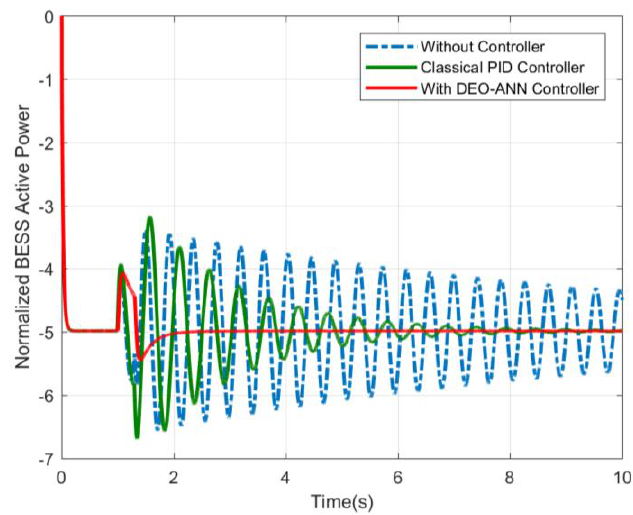
Figure 24. Injected real power by the BESS.